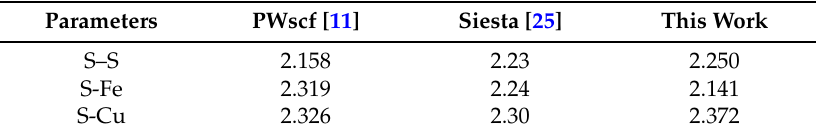
Table 2. Reconstructed (001)-S surface.